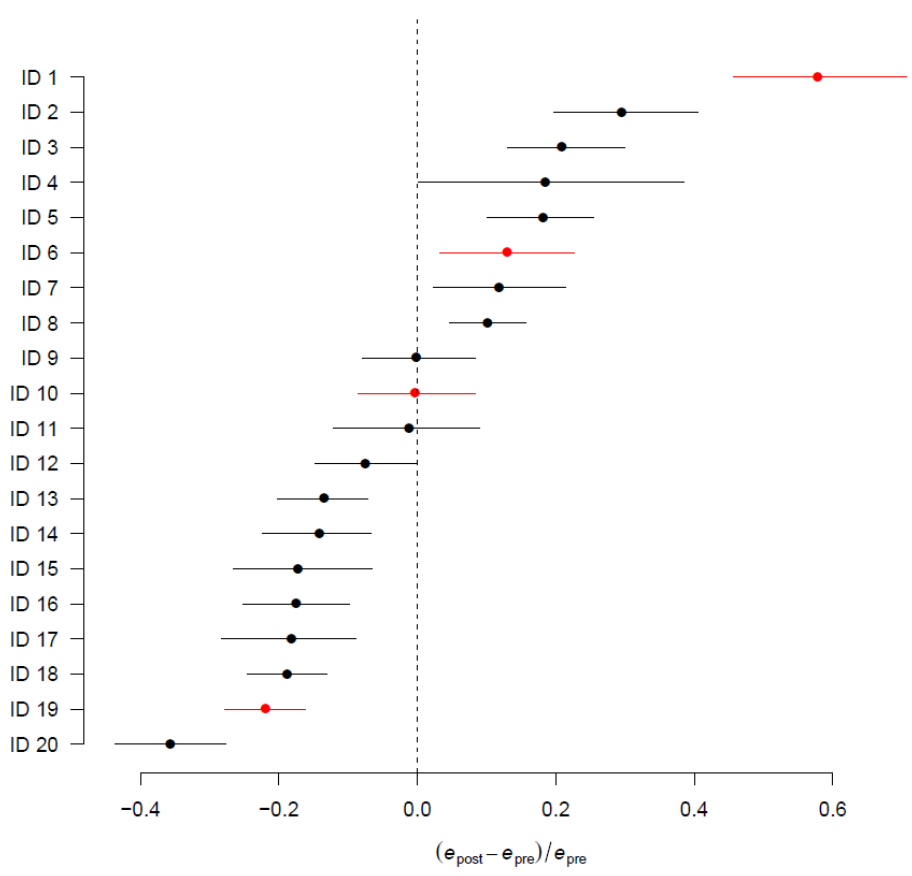
Figure 3. Forest plot summarizing the intraoperative performance d = ( e post − e pre )/ e pre for each center, measuring the difference d in expected mortality between pre- and post-operative models at OTR discharge admission and OTR admission discharge ( e post and e pre , respectively), normalized by ORT expected pre-operative mortality epre. In red, we highlighted the four centers reported as examples in Figure 4.